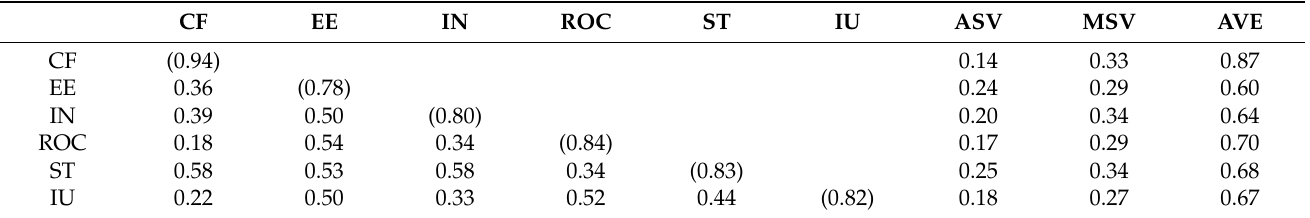
Table 3. Square root of AVE and